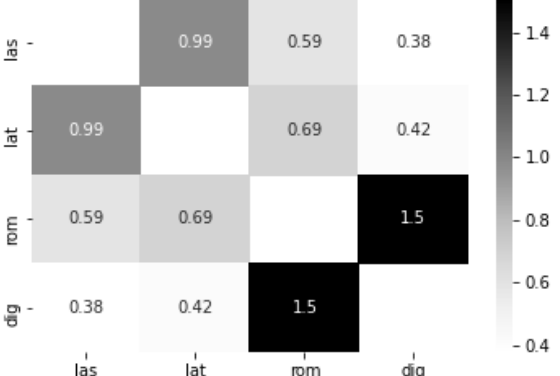
Figure 8. Heatmap illustrating the semantic proximity of word embeddings models based on the mean of weighted similarity scores of the top ten semantic neighbours in the four corpora (Digest, ROMTEXT, LatinISE, Lasla).